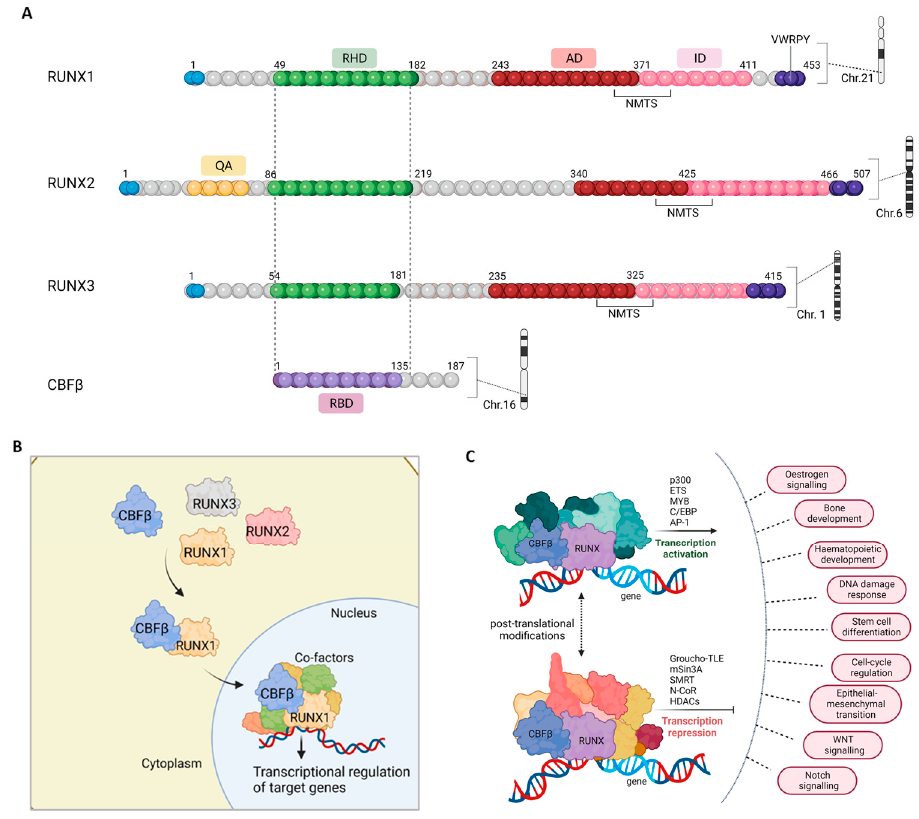
Figure 2. The RUNX/CBF β complex. ( A ) The human RUNX proteins are encoded by 3 RUNX genes, RUNX1 (on chromosome 21), RUNX2 (on chromosome 6) and RUNX3 (on chromosome 1), while CBF β is encoded by the CBFB gene on chromosome 16. The Runt-homology domain (RHD) on RUNX proteins binds to the Runt-binding domain (RBD) on CBF β to allow formation of the CBF complex. The activation domain (AD), inhibitory domain (ID) and nuclear matrix targeting signal (NMTS) are indicated. The QA region on RUNX2 is an extended region of glutamine-alanine repeats that differentiates it from the two other RUNX family members. The carboxy-terminal VWRPY motif is used in the interaction with co-factors. ( B ) CBF β interacts with members of the RUNX family within the cytoplasm. Once bound to any of the three RUNX proteins, in this case RUNX1 is depicted, the complex is translocated into the nucleus where it can bind to DNA and regulate transcription. Recruitment of various co-factors determines the fate of transcriptional regulation of RUNX/CBF β target genes. ( C ) The core binding factor complex works in conjunction with an array of transcription co-activators and co-repressors to regulate crucial cellular pathways. Figures created using Biorender.com and taken from the PhD thesis of Adiba Khan, University of Glasgow 2022.